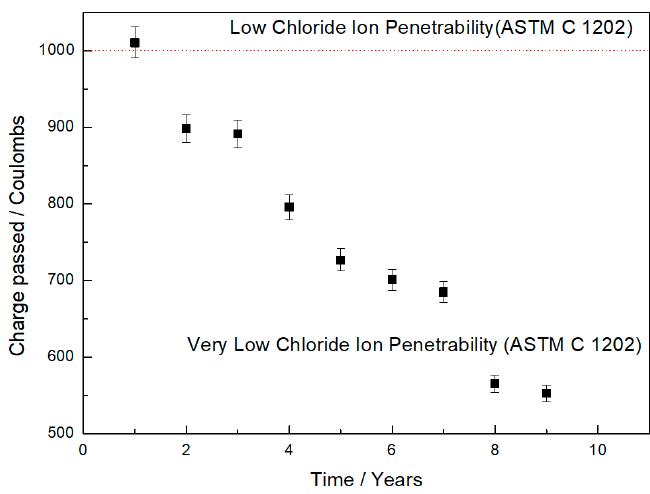
Figure 6. Determination of resistance to chloride ion penetration.